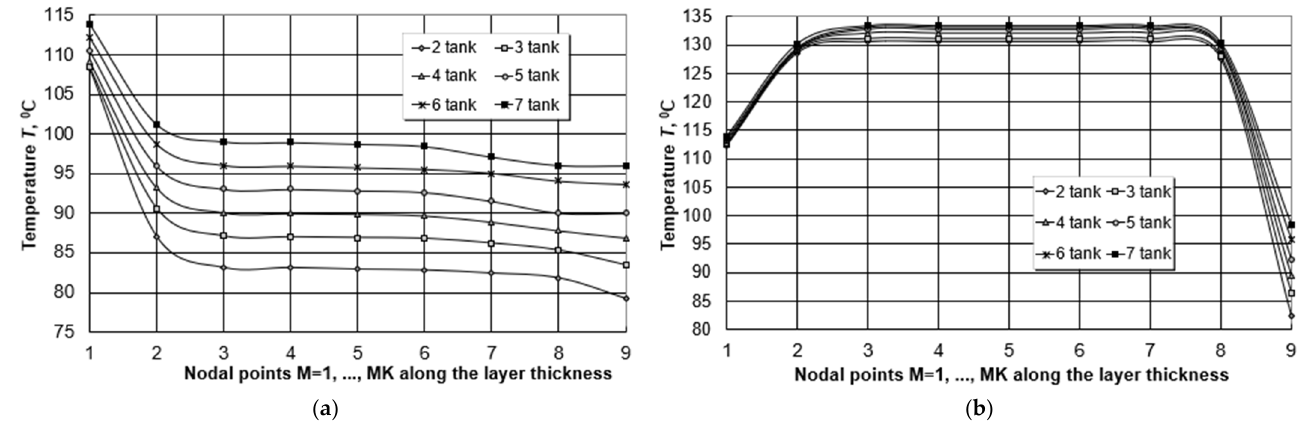
Figure 6. Temperature change T of compressed castor seed in the frying process along the layer height in sections r = R /2 ( а ) and r = R ( b ) in each vat at 8 min.